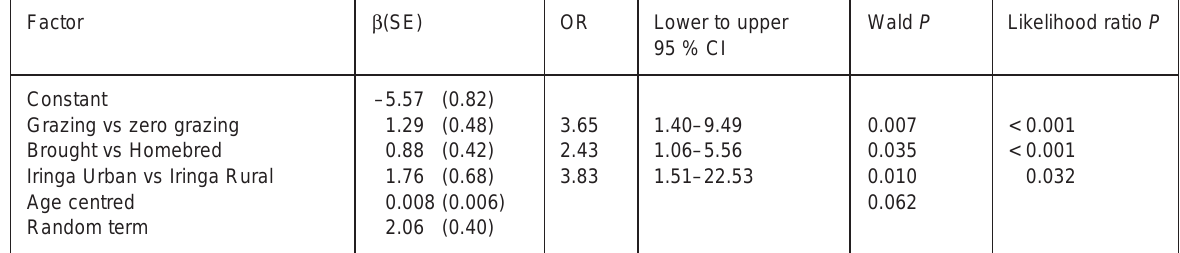
TABLE 4 Final logistic binomial multiple regression for sero-prevalence of Babesia bovis in dairy cattle, Iringa, Tanzania (January to April 1999)